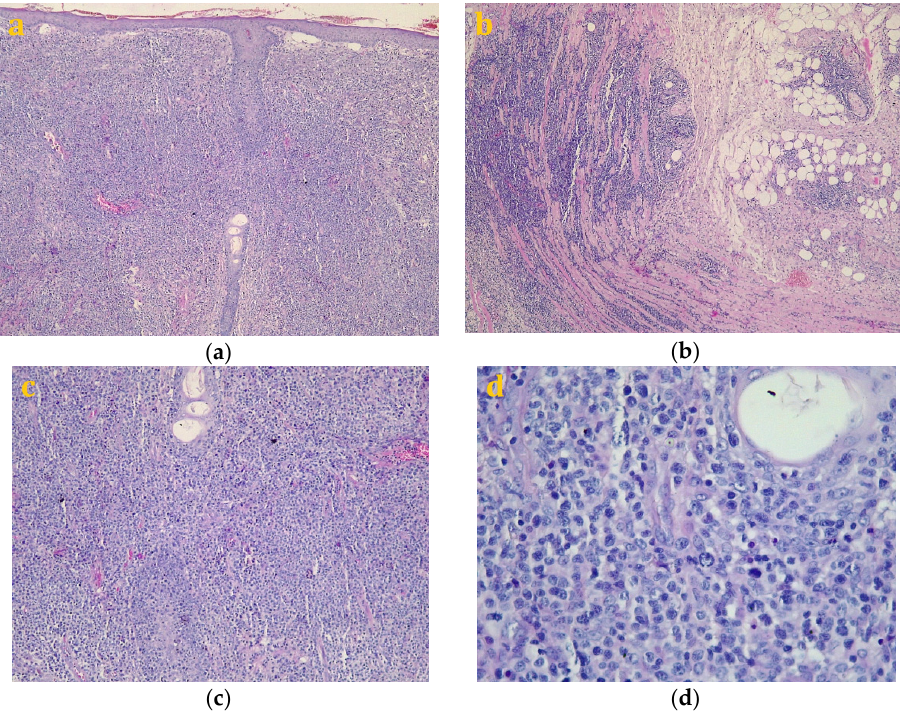
Figure 2. Pathology diagnosis of a primary cutaneous peripheral T-cell lymphoma not otherwise specified—Hematoxylin–Eosin staining. ( a , Magnification 40×, b , magnification 100×, c , Magnification 200×, d , Magnification 400×).